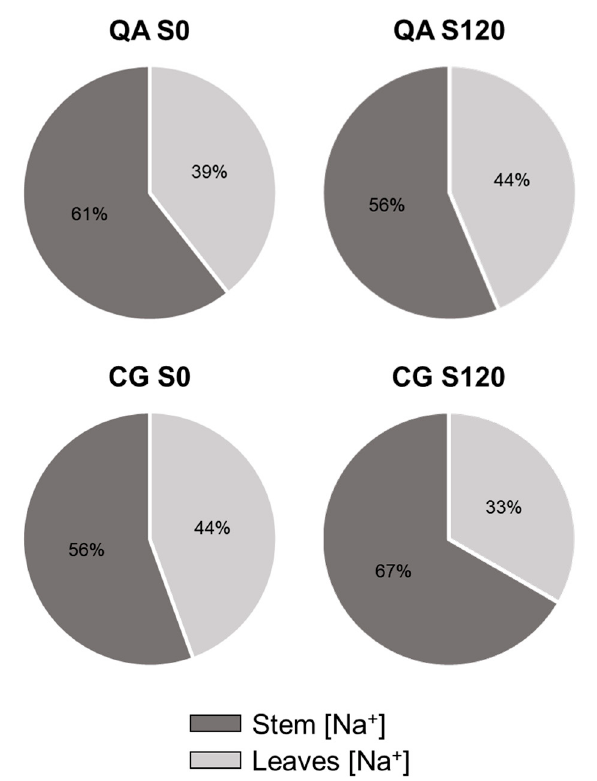
Figure 5. Sodium concentration portioning between leaves and stems of the commercial cultivar (QA) and the landrace (CG) grown at control (0 mM) and high salinity (120 mM) at DAT 168. The number in the pie graph indicates the percentage of sodium found in the different plant portions compared to the total sodium concentration between leaves and stems.